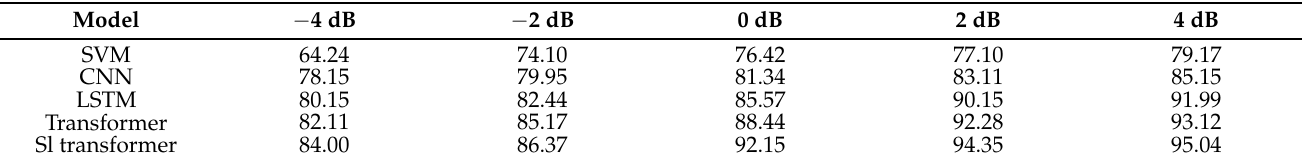
Table 6. The F1-score table of applying SSA